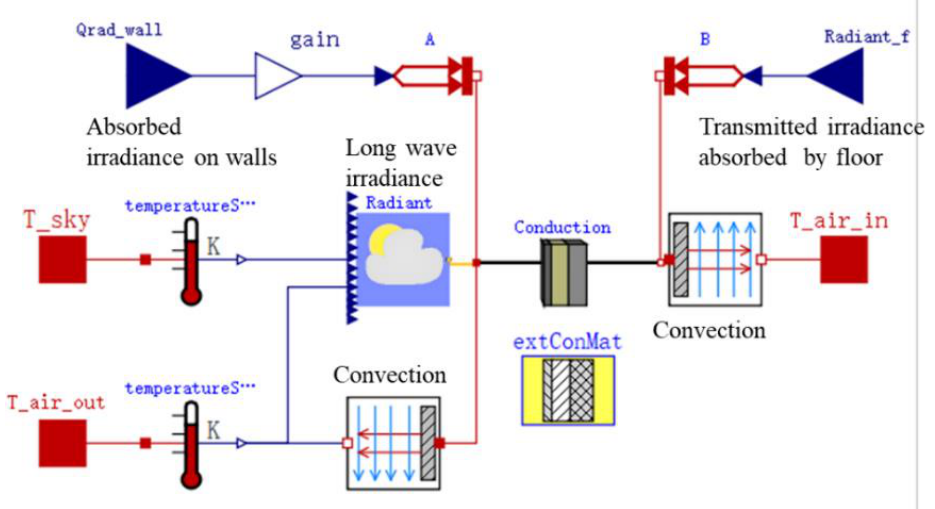
Figure 5. Numerical simplified model for a wall.